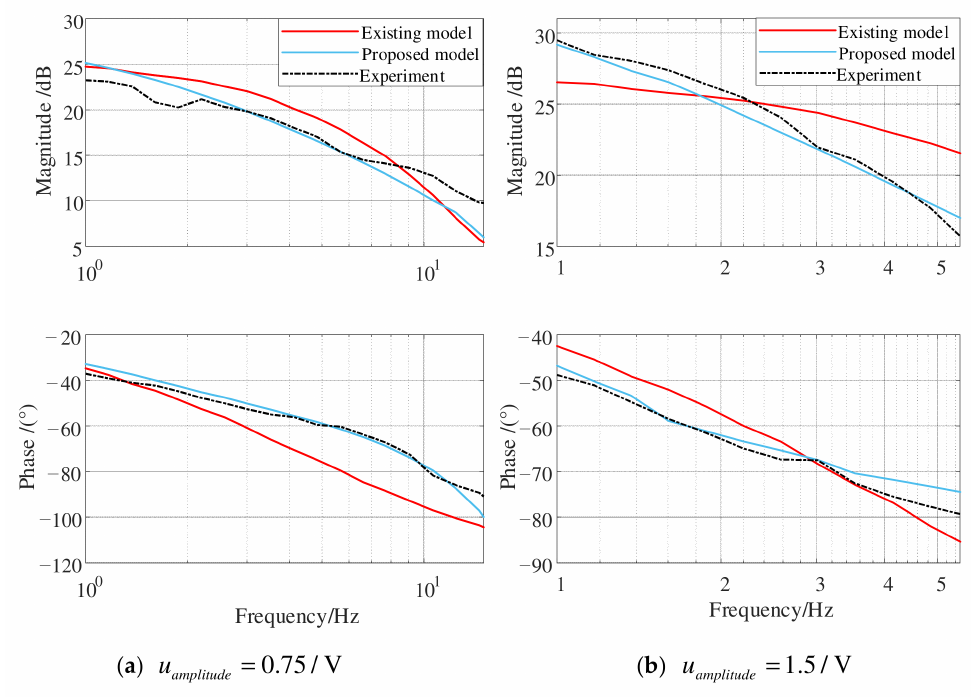
Figure 17. Simulated and experimental frequency responses under an